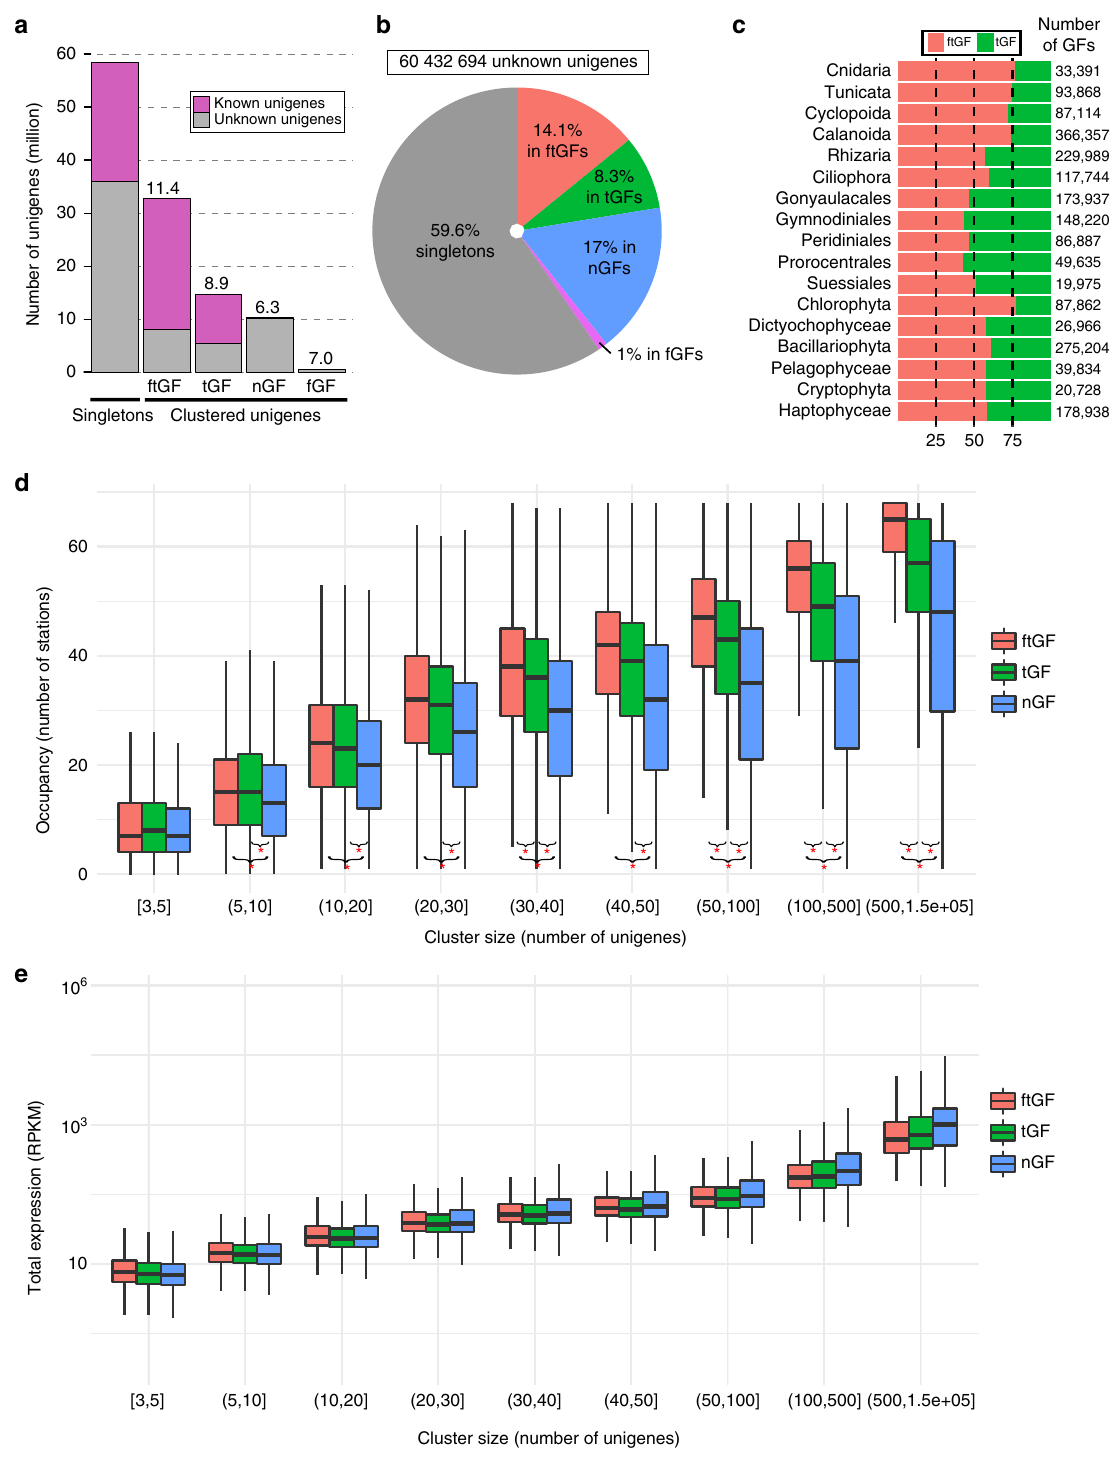
Fig. 4 Eukaryote gene catalog clustering and characterization of novel genes. a Global repartition of unigenes based on the gene catalog clustering. Unigenes were considered as singletons if they are in clusters of less than three units. Gene families are novel (nGF), taxonomically assigned (tGF), functionally assigned (fGF), or both (ftGF) (Methods). Numbers above each bar indicate the numbers of unigenes per cluster. b Distribution of unknown unigenes in the different categories described in a . c Ratio of tGFs vs. ftGFs in the main taxonomic groups. The total number of GFs assigned to each taxonomic group is indicated on the right. d Distribution of GF occupancy for the three main GF categories. GFs are classi fi ed according to their size ( x - axis) and the y -axis indicates the number of stations where the GF family is expressed (at least one unigene detected with a coverage of more than 80% of the unigene length). Kolmogorov-Smirnov tests with p < 10 – 5 between occupancy distributions are indicated with red stars. e Distribution of mean expression levels of the three different categories of GFs among all samples. GFs are classi fi ed according to their size ( x -axis). The expression of a GF in a sample was determined by the sum of the expression of its unigenes in